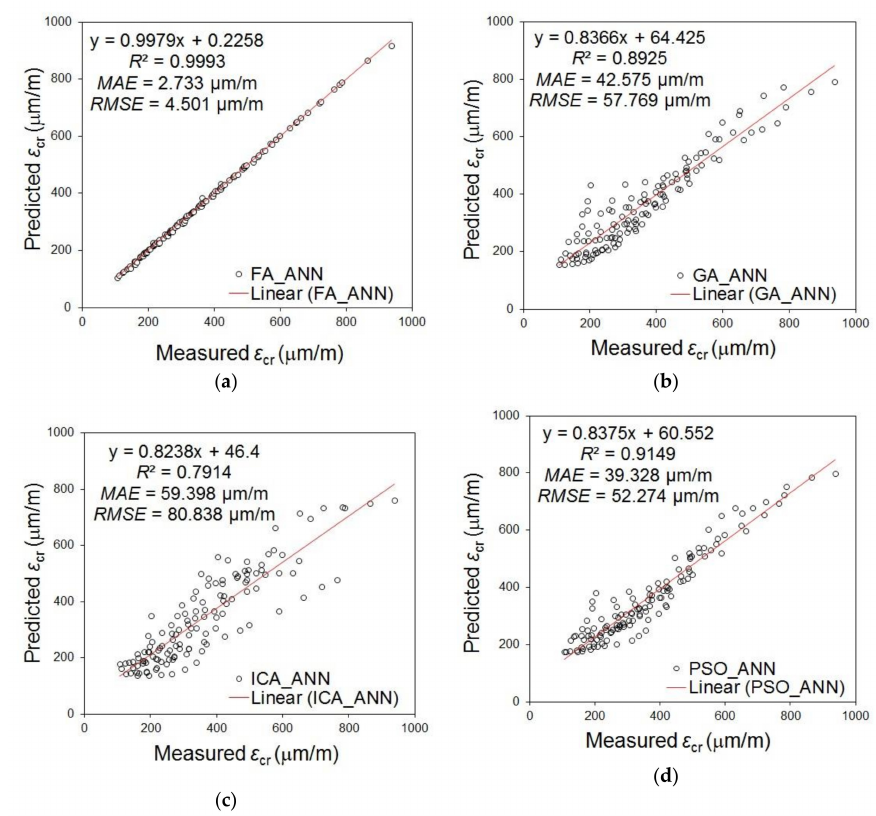
Figure 10. Results of experimental and computational values for the creep strain parameter using the ANN model modified by: ( a ) FA; ( b ) GA; ( c ) ICA; ( d )